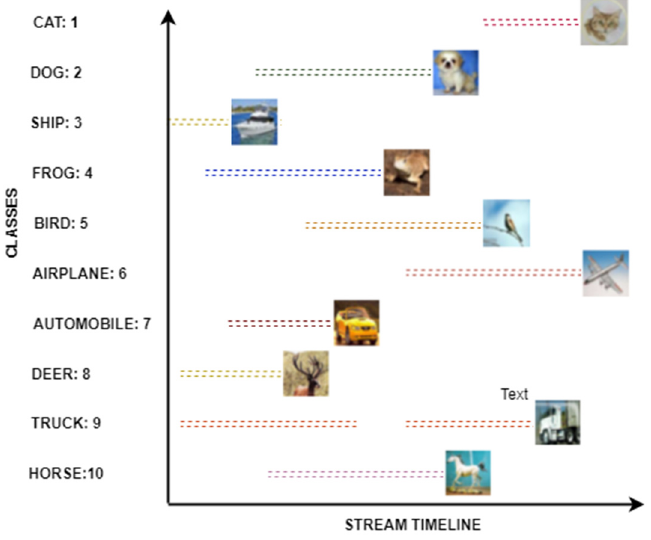
Figure 4. CIFAR10 dataset stream pipeline to simulate the concept drift scenarios.